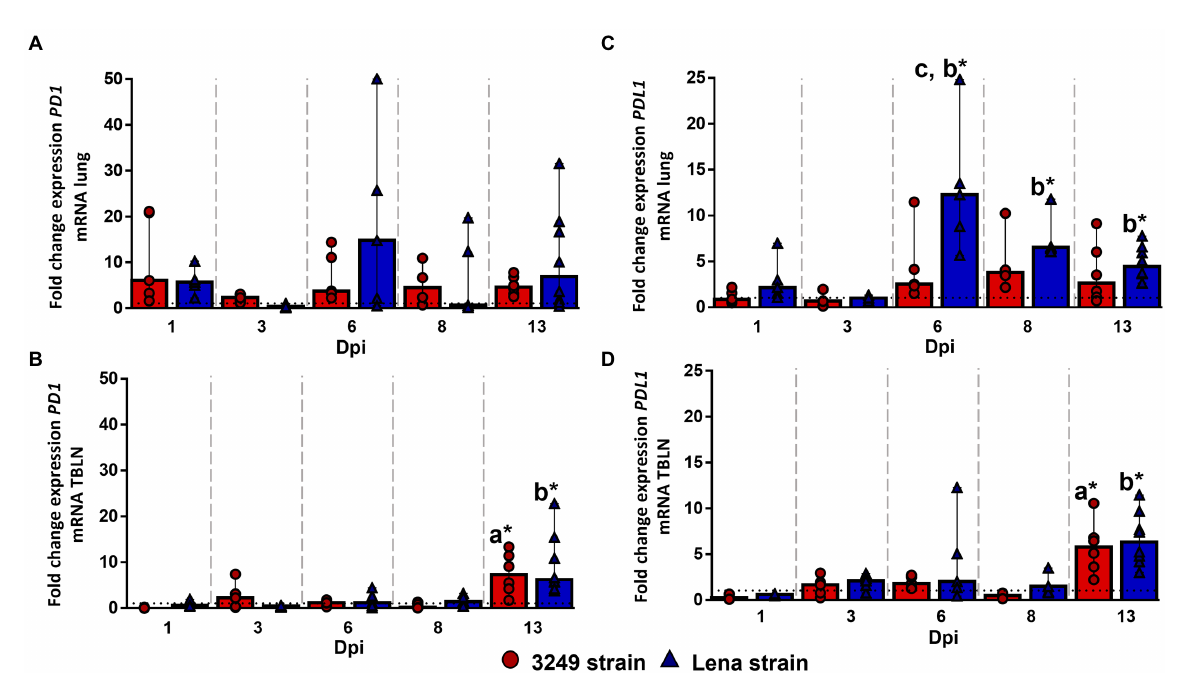
FIGURE 5 Relative mRNA expression of PD1 and PDL1 mRNA. Graphs show fold change expression of PD1 mRNA in lung (A) and tracheobronchial lymph node (TBLN) (B) , and of PDL1 mRNA in lung (C) and tracheobronchial lymph node (TBLN) (D) . Columns represent median with interquartile range (IQR). Individual values for each animal from low virulent 3249- (red circles) and virulent Lena- (blue triangles) infected animals are presented. Dashed line represents the expression of PD1 and PDL1 mRNA from control group in each organ. “a” indicates a significant difference between the 3249 and control groups, “b” between Lena and control groups and “c” between Lena and 3249 groups (* p ≤ 0.05 and ** p ≤ 0.01). Dpi, days post-